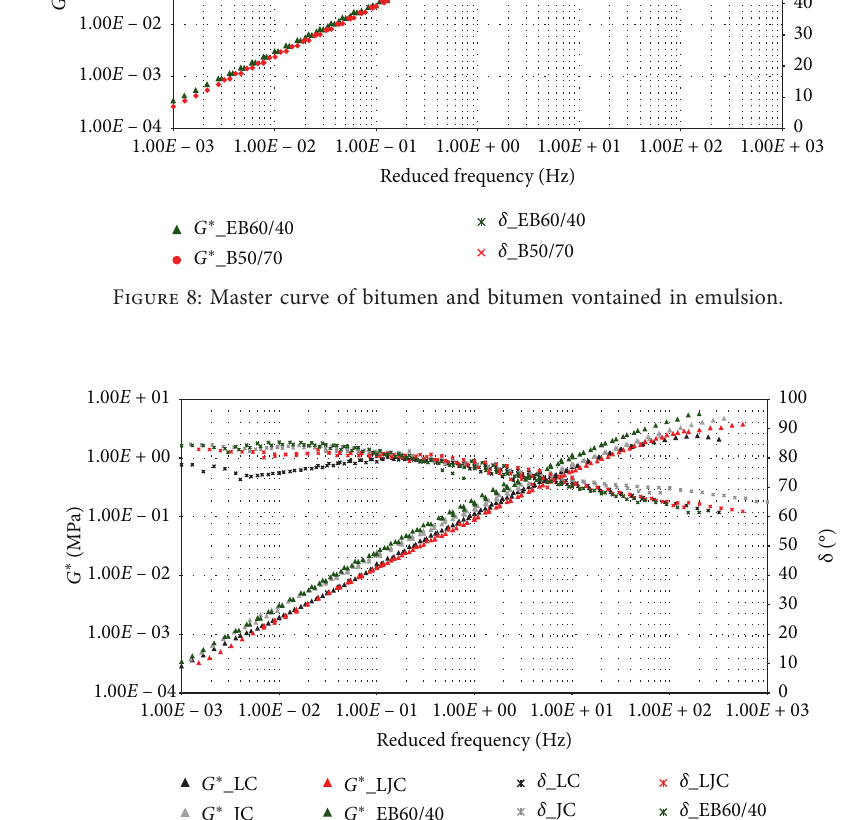
Figure 9: The master curves of the cold mastics after 3 days of curing time in an oven heated to 60 ° C and